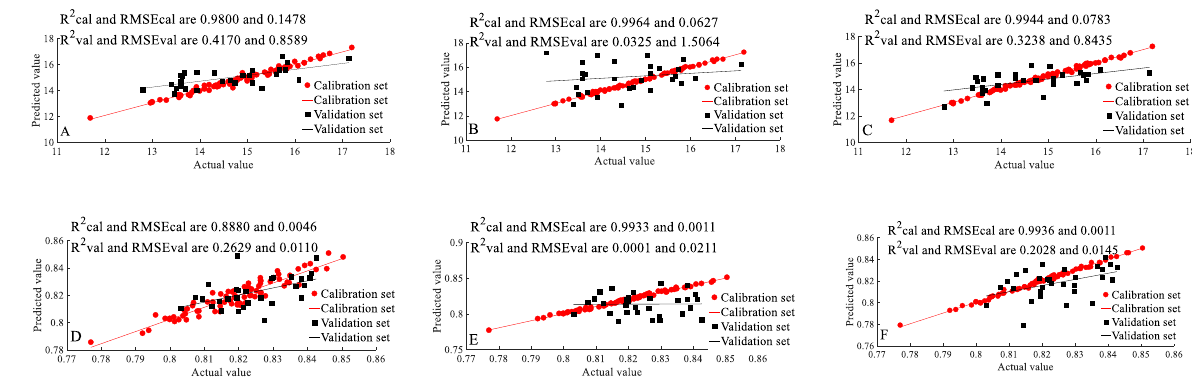
Figure 1. TSSC and water content detection based on raw spectrometer data from 400–1100 nm at the ( A , D ) stem end position, ( B , E ) equator position, ( C , F ) blossom end position; ( A – C ) TSSC detection, ( D – F ) water content detection.